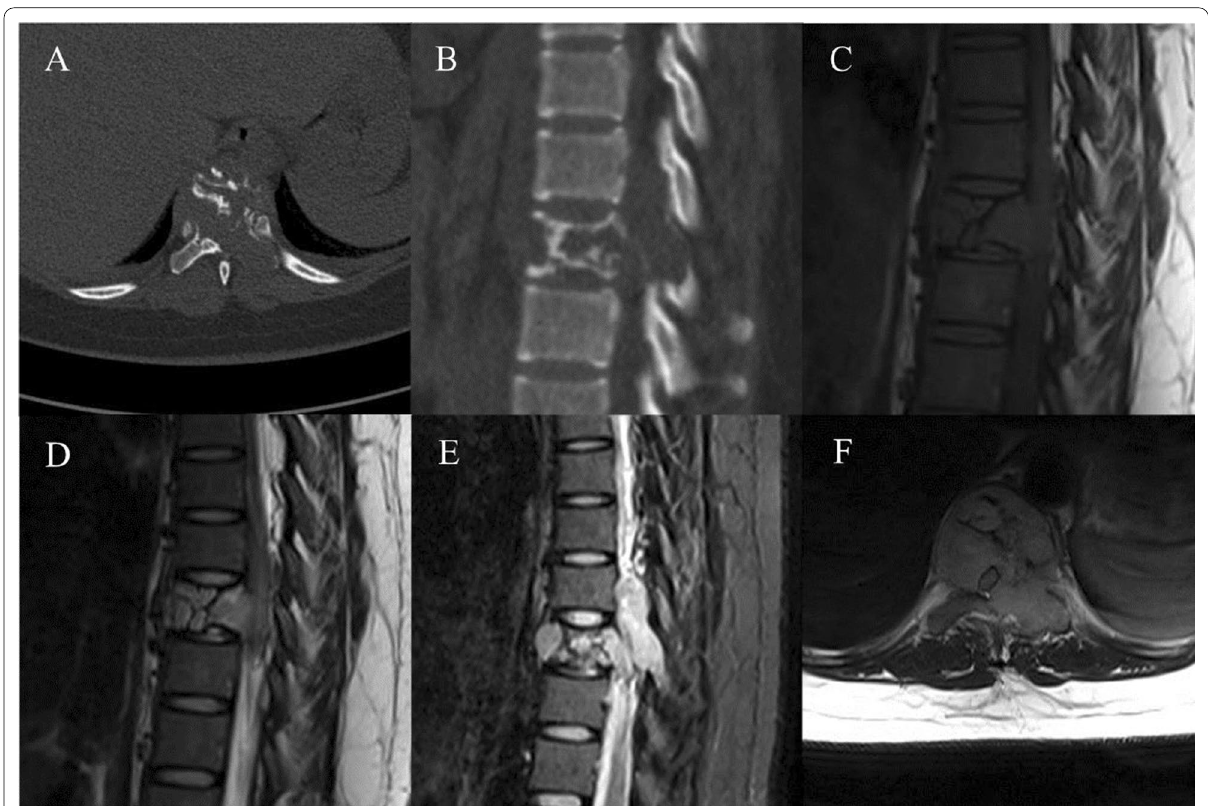
Fig. 1 A 21-year-old woman with EHE (case 2). a Axial CT showing an ill-defined expansile osteolytic lesion of T9 with extension into the left posterior elements, containing thickened residual bone trabeculae and no sclerotic margin. b Sagittal CT showing a mild vertebral compression. c MR T1WI sagittal view showing the intermediate signal intensity (SI) of the lesion with a low-SI septum. d T2WI sagittal view showing that the tumor has high SI. e Fat suppression T2 sequence showing high SI of the lesion. f MR T2WI axial view showing a soft-tissue mass encroaching the spinal canal, which caused spinal cord